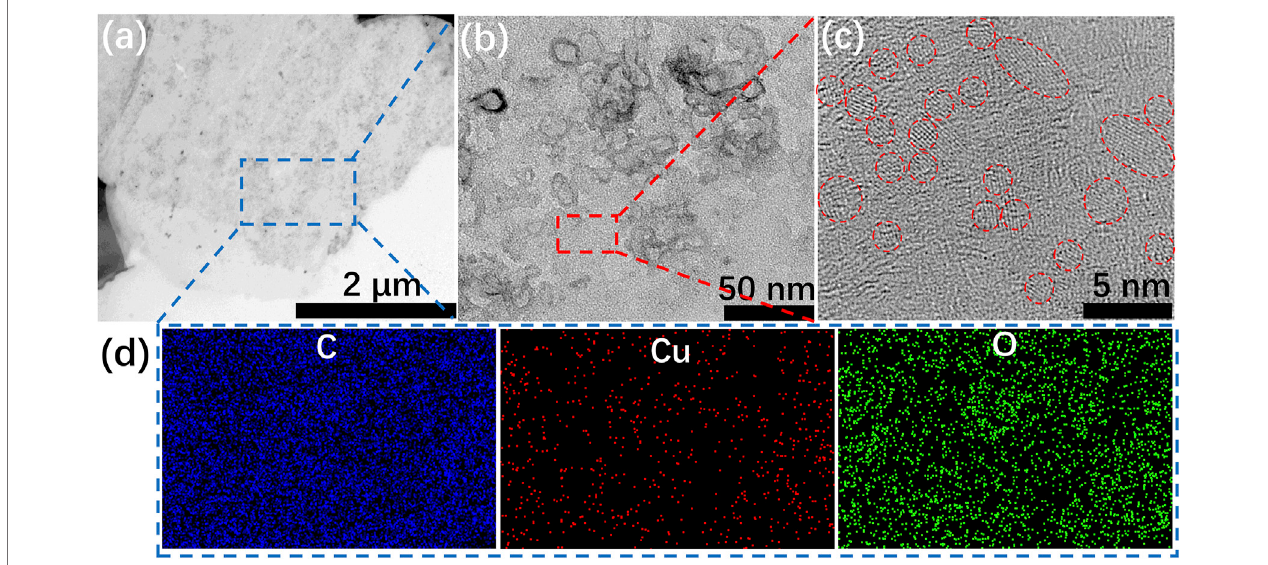
FIGURE 3 | (A – C) TEM images of Cu/GG hydrogel; (D) elemental mapping images of the selected area labeled in (A)